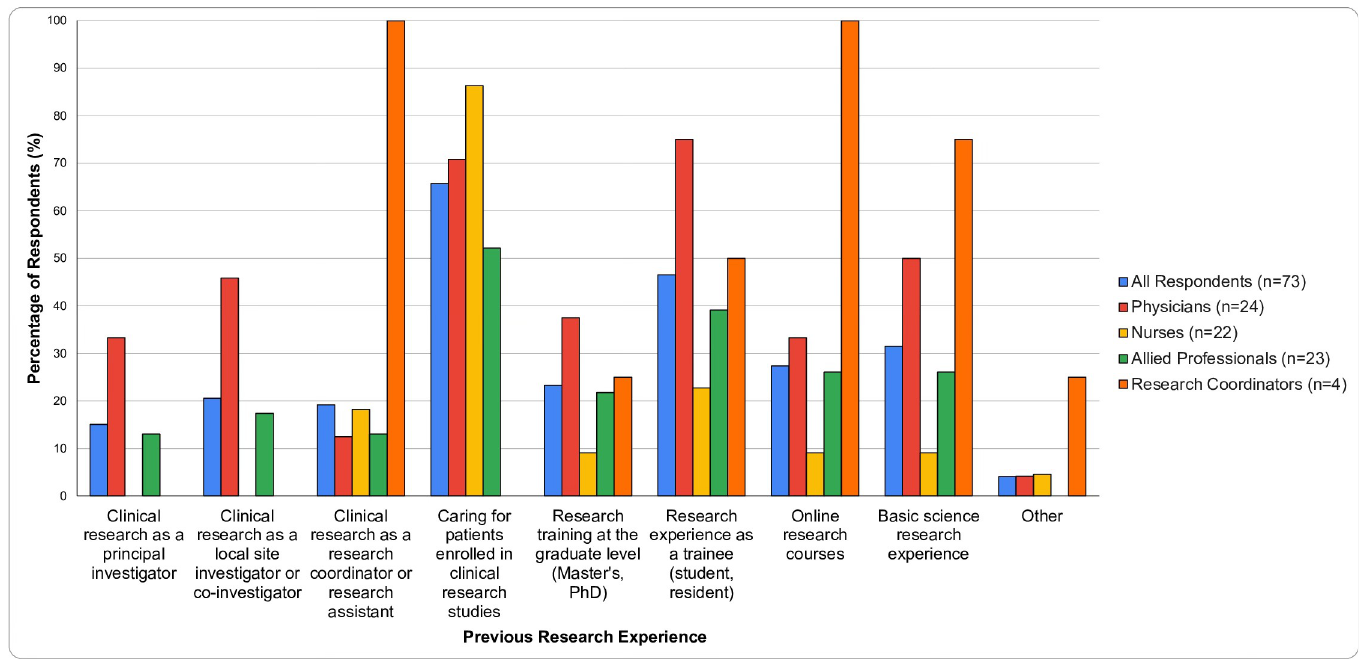
Fig 2. Participants previous research experience (N =